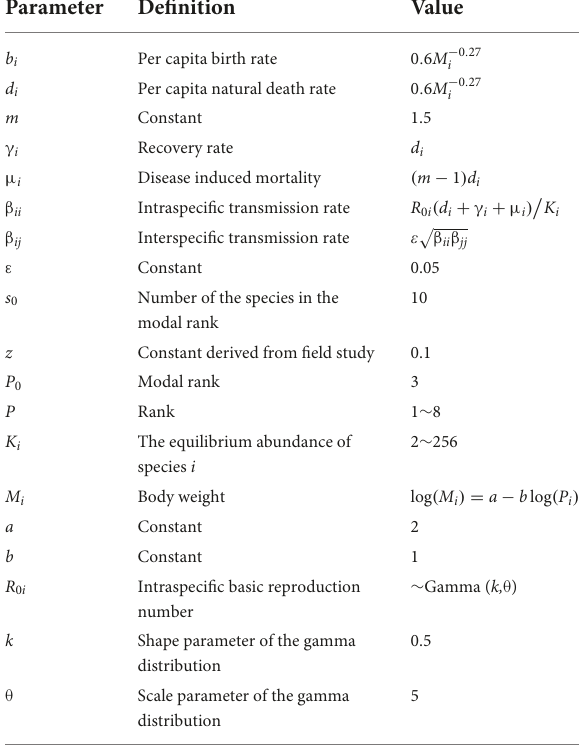
TABLE 1 Parameters, definitions, and values for generating the global species